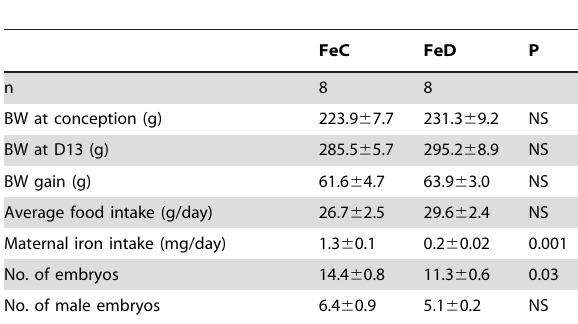
Table 1. Maternal weight gain, food intake and reproductive performance (FeC =control iron; FeD= iron deficient; BW=body weight; D13=day 13 of pregnancy; NS= not